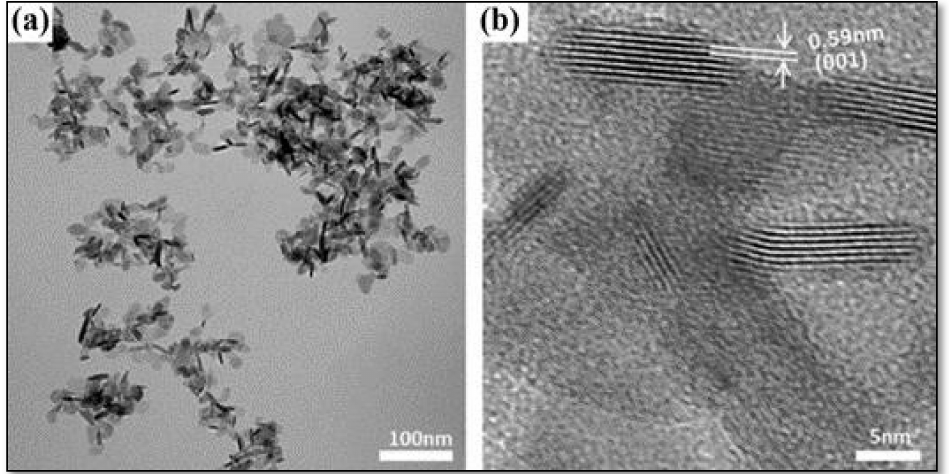
Figure 7. ( a ) TEM and ( b ) HRTEM images of as-prepared SnS2 nanosheets. Adapted with permission from [112]. Copyright 2022, Wiley